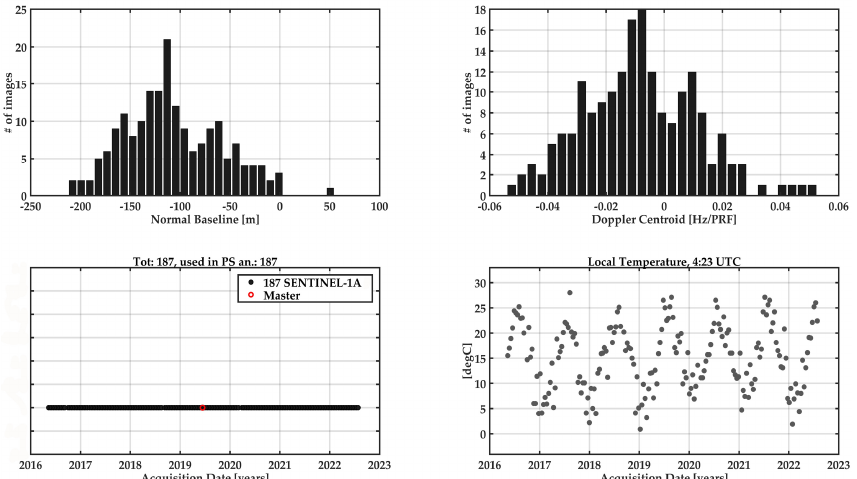
Figure 5. Dataset of the Descending Orbit. The upper left graph illustrates the normal baseline distribution of image pairs. The upper right graph illustrates the Doppler centroid distribution of image pairs. The lower left graph illustrates the temporal baseline. The lower right graph illustrates the local temperature per acquisition date.